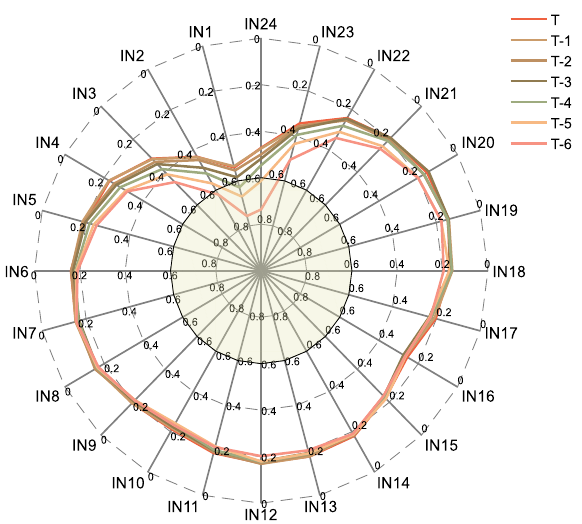
Figure 9. MIC of historical load for dataset 4.